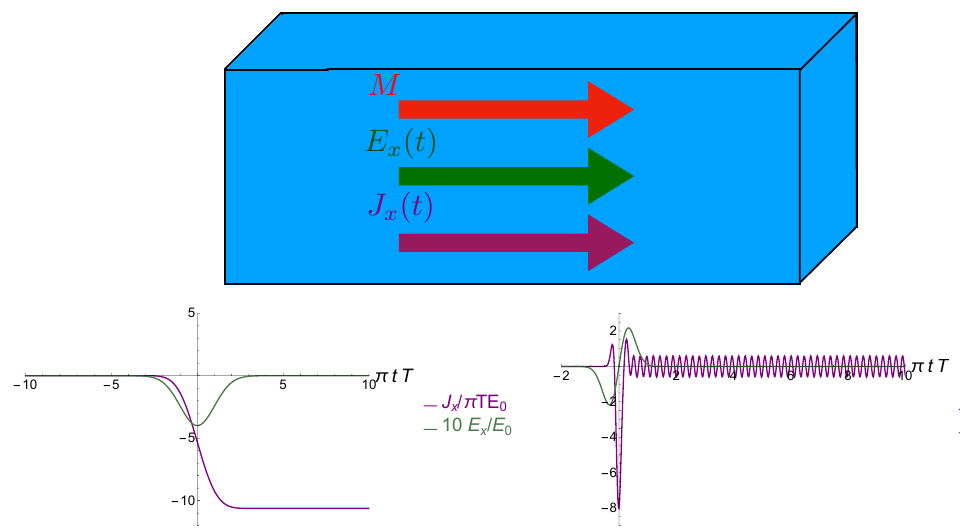
Figure 1 . An illustration of a physical setup where an initially thermally equilibrated system is placed in a constant magnetic (cid:12)eld M and a time dependent electric (cid:12)eld E x = (cid:0) @ t A x (top). In the presence of anomalies we observe two distinct e(cid:11)ects on the resulting current J x . A trailing e(cid:11)ect where the current follows the behavior of the gauge (cid:12)eld (bottom left) and an anomalous resonance where the current oscillates for time scales much longer than the perturbation associated with the driving electric (cid:12)eld (bottom right). The bottom plots were evaluated at T the temperature and (cid:13) the strength of the anomaly. In both bottom plots, E 0 is a reference value for the electric